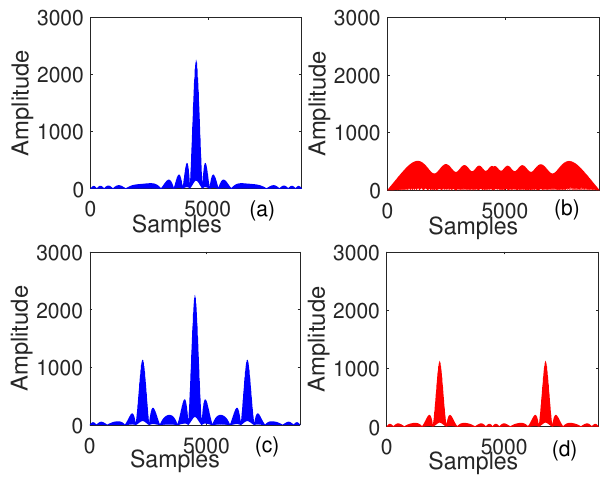
Figure 2. Comparison of ( a ) auto-correlation and ( b ) cross-correlation of S 1 and S 2 for up and down chirp signals and ( c )auto correlation and ( d ) cross-correlation of Tx 1 and Tx 2 for orthogonal chirp